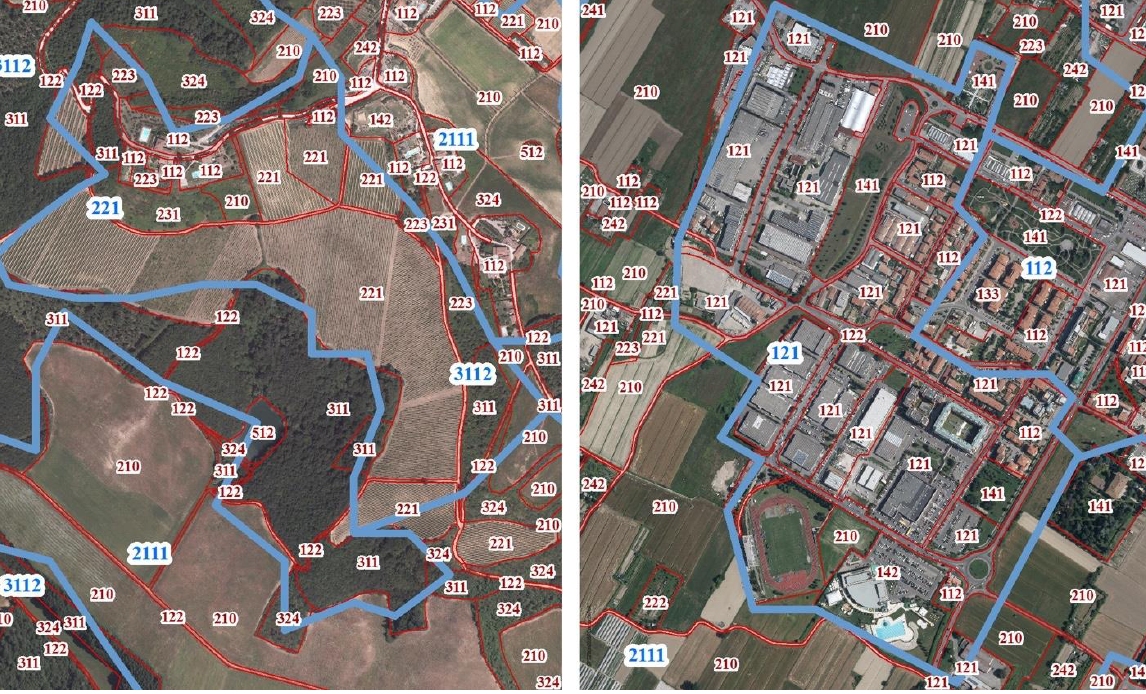
Figure 2. The two maps represent: in blue LULC database from EEA project (1:100.000), in red LULC database used as proxy to quantify ecosystem services (1:10.000). The greater cartographic detail of the LULC database at 1: 10,000 scale used by our research allows to map ESs provided by agricultural and forest areas and urban green areas not present in the 1: 100,000 scale dataset and to evaluate the effective contribution of artificial areas to the supply of ESs. The image on the left represents a portion of the countryside around San Gemignano (Siena); the one on the right, instead, a portion of peri-urban territory near Campi Bisenzio